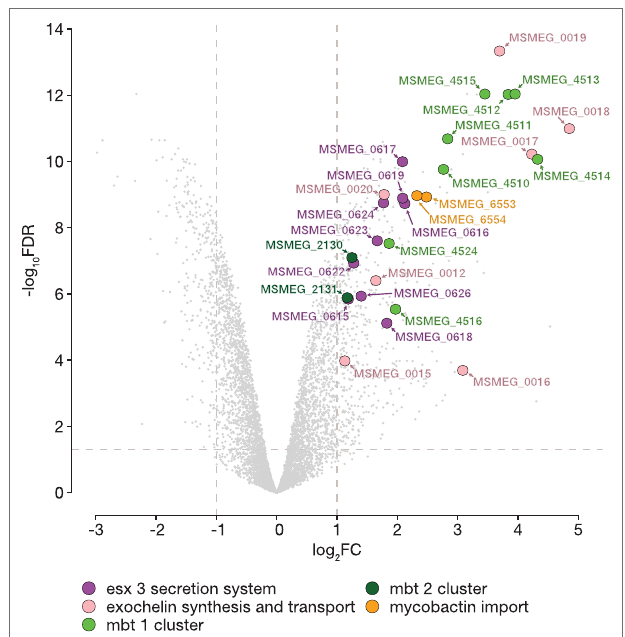
FIGURE 3 | BRACO-19 compound affects M. smegmatis MC 2 155 iron metabolism. Volcano plot indicates the distribution of DEGs for the M. smegmatis MC 2 155 exposed to BRACO-19 ligand. Log transformed fold changes (log 2 FC) are plotted on the x -axis, and significance ( − log 10 FDR) is plotted on the y -axis. Colors denote genes involved in iron metabolism with a significantly increased level of expression (FDR < 0.05, log 2 FC >